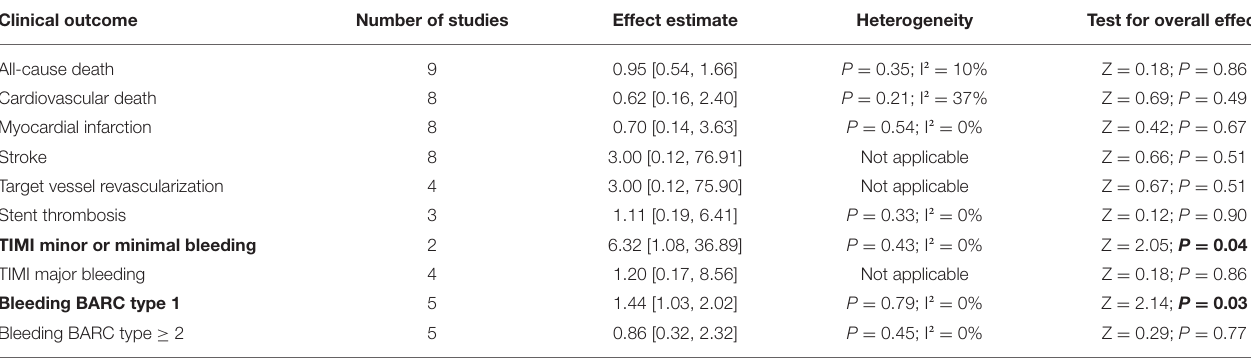
TABLE 4 | Meta-analysis results of clinical outcomes. Clinical